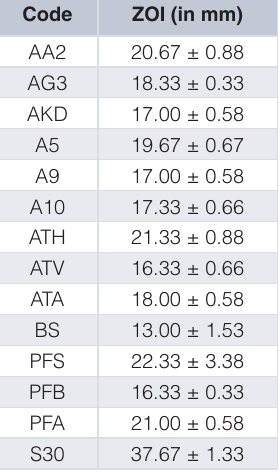
Table 4. Inhibition zone made by the isolates used as biocontrol agents against Ralstonia spp. using agar well diffusion technique. All the data are generated using three replications. Values are means (±SE) zone of inhibition (ZOI) in mm against Ralstonia spp. (n=3, P <0.05). S30 denotes streptomycin sulphate used at the dilution of 30 mcg. 5 mm diameter of punch hole is included in the data. Code is in reference to Table 1.